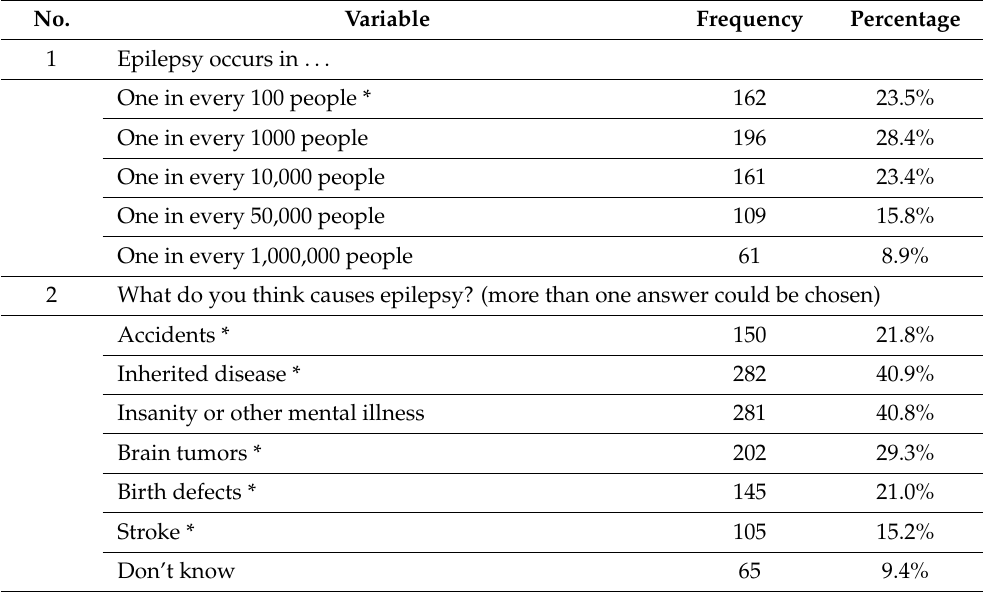
Table 2. Participants’ responses to knowledge